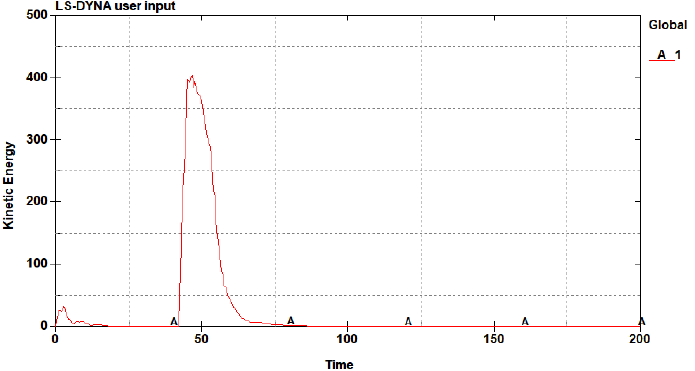
Figure 4. Variations in the kinetic energy with time.